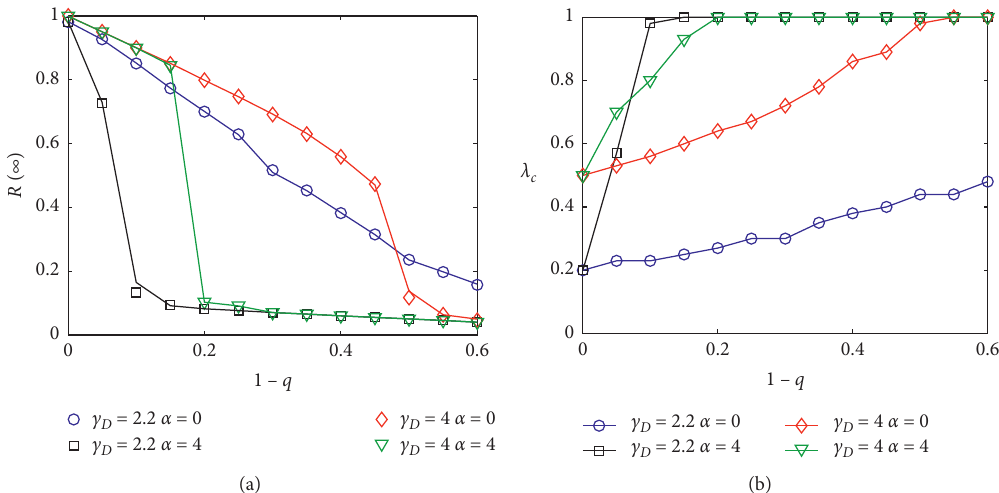
Figure 3: The effects of the immune ratio 1 − q on social contagions under different degree exponent c adoption size R ( ∞ ) versus 1 − q when λ � 1 and (b) the threshold λ c versus 1 − q